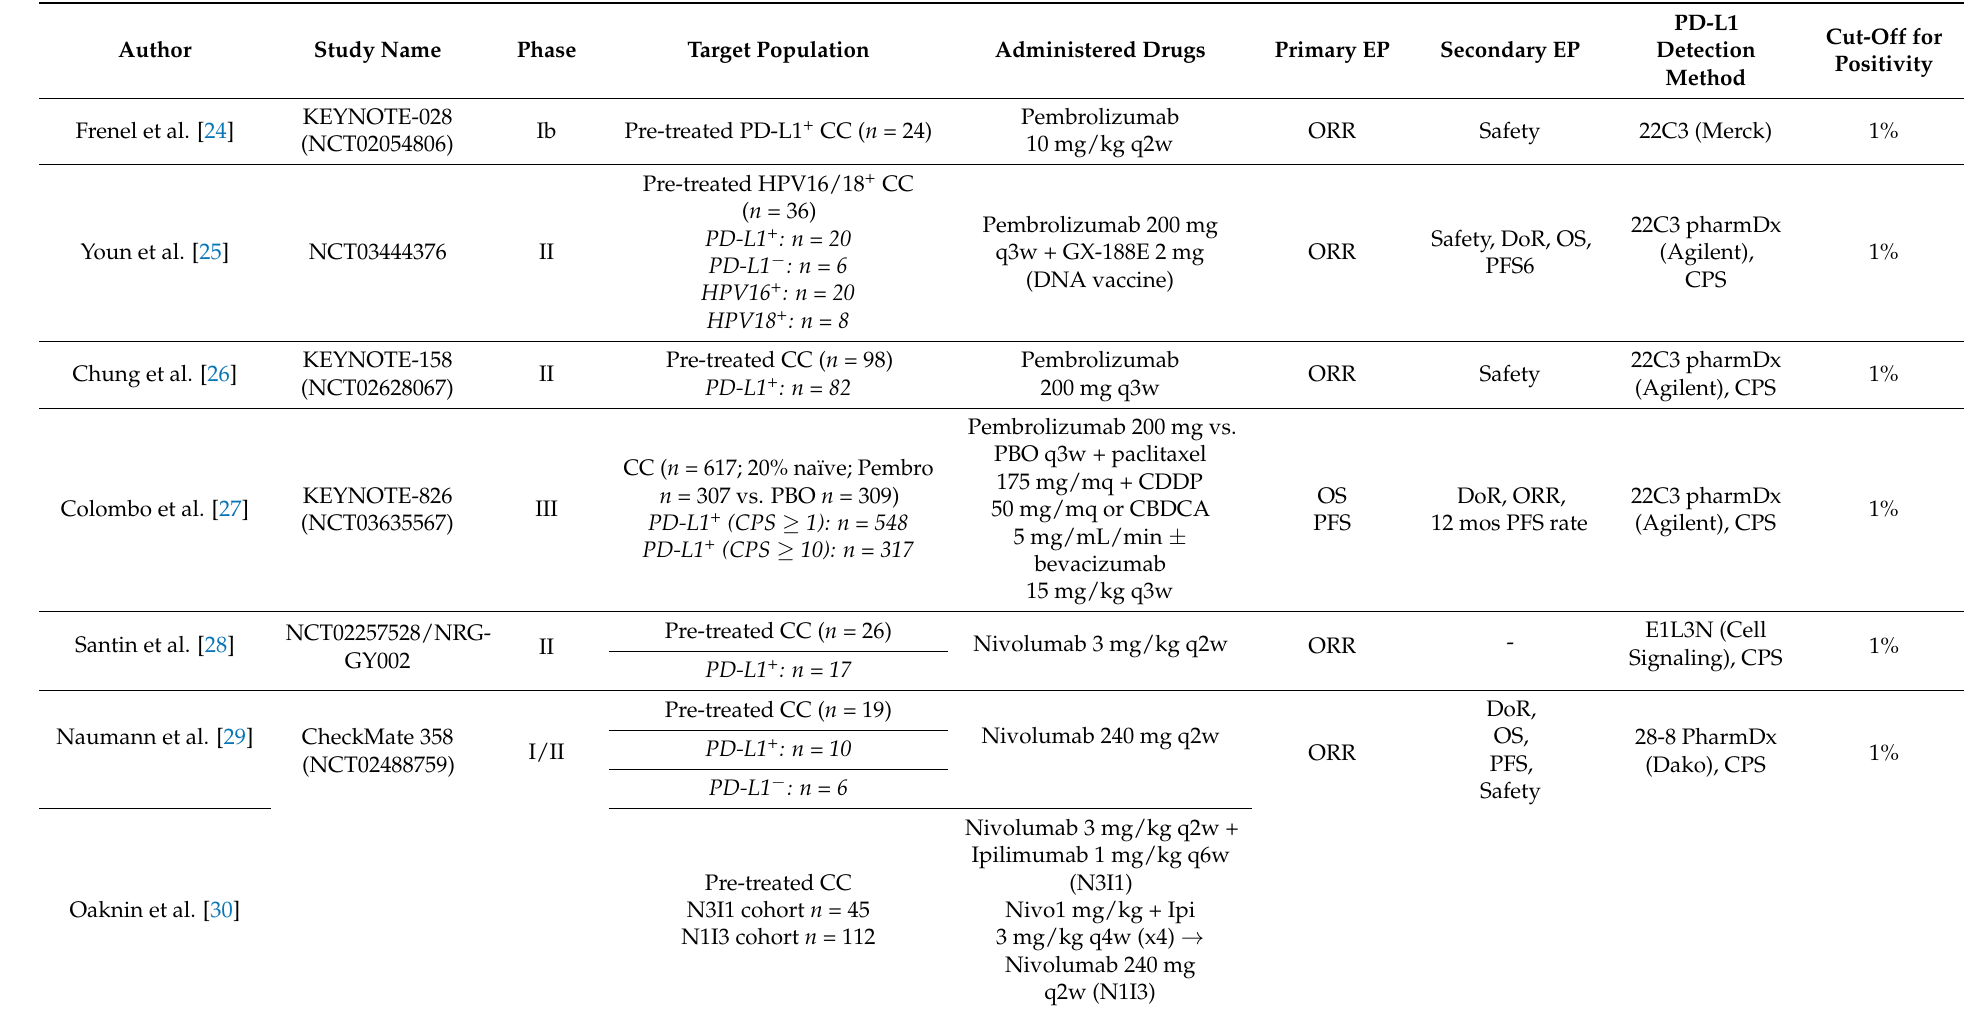
Table 1. Main characteristics of trials of ICIs in advanced